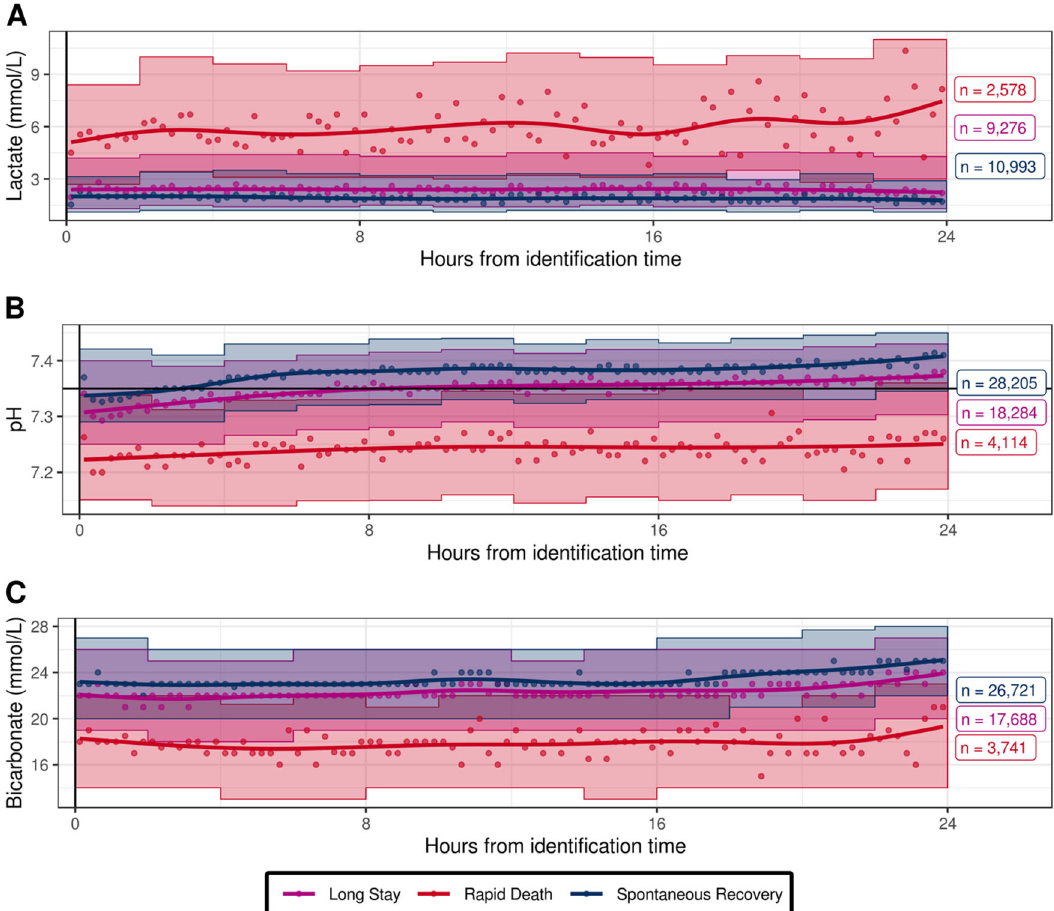
Fig. 5 Trends of acidotic parameters over time by patient status 48 h after identi fi cation time. Smoothed trends between the identi fi cation time and 24 h afterwards by patient subtype for lactate ( a ), pH ( b ), and bicarbonate ( c ). Points represent the median parameter values in a quarter-hour interval relative to identi fi cation time. Intervals represent the 25th and 75th percentiles of parameter values in a 2 h window relative to identi fi cation time. GAM smoothing splines highlight trends. Number of subjects with plausible values in each category is shown on the right of each